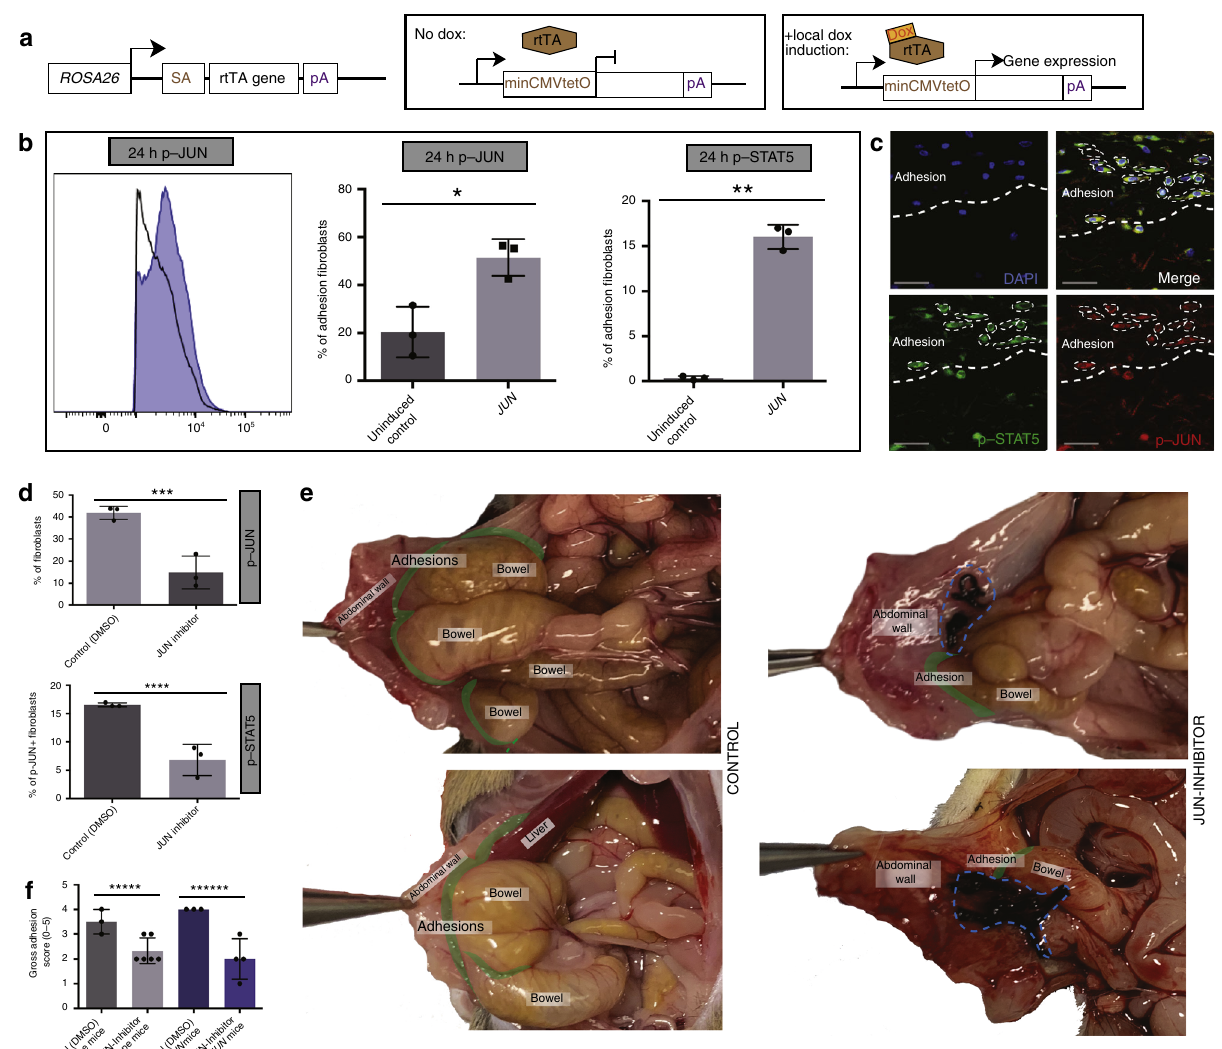
Fig. 5 JUN is an early promotor of abdominal adhesion fi brosis. a Schematic illustrating the targeting construct used in the doxycycline (dox)-inducible JUN mouse model. In this construct, rt TA is expressed at the endogenous ROSA26 promotor. With dox induction, rtTA undergoes nuclear translocation to activate the Tet-responsive element (minCMV-tet(o)) driving expression of JUN . SA splice acceptor, pA poly(A) sequence. b Representative phospho- fl ow-cytometry analysis for phosphorylated (phospho-) JUN (left and middle panels), and phospho-STAT5 (right panel) expression in abdominal adhesion fi broblasts isolated from JUN mice 24 h after adhesion surgery (with local induction with doxycycline at the time of adhesion formation) compared with vehicle control. n = 3 biological replicates. c Immuno fl uorescent assessment of phospho-JUN and phospho-STAT5 co-expression in mouse abdominal adhesion tissue. Thick white dotted line indicates edge of adhesions interface, co-expressing cells highlighted with thin white dotted lines. n = 3 biological replicates. Scale bars, 25 μ m. d Quantitation of phospho- fl ow-cytometry analysis showing a signi fi cant decrease in phospho-JUN (top panel) and phospho- STAT5 (bottom panel) expression with application of JUN inhibitor versus vehicle control in JUN mice at 24 h. n = 3 biological replicates per condition, datapoints represent averages of technical replicates. e Representative gross images of mouse adhesions at POD 3 treated with (vehicle, DMSO) control (left panels) versus JUN inhibitor (right panels). Adhesion interface highlighted in green, structures as indicated in fi gures, black sutures (circled with blue dotted line) visible on inhibitor specimens are nidus for adhesion formation (these are not visible on control specimens as they are covered with bowel that is adhesed to the abdominal sidewall). n ≥ 3 biological replicates per condition per treatment. f Gross assessment (using an adhesion severity grading score established by Tsai et al. 2018 19 ) of adhesion severity following in vivo inhibition of JUN using JUN inhibitor (T-5224) versus vehicle control in JUN ( JUN expression induced with doxycycline in all JUN mice used) and wild-type mice at POD 3. n ≥ 3 biological replicates per condition per treatment. Data and error bars represent mean ± SD. * P = 0.01, ** P = 0.0001, *** P = 0.004, **** P = 0.003, ***** P = 0.01, ****** P = 0.009, unpaired two-tailed t- test. Source data are provided as a Source Data fi